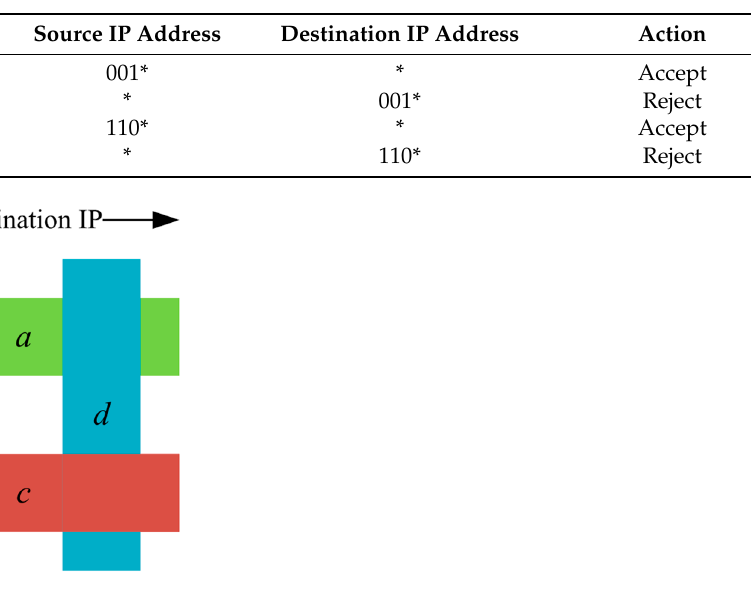
Figure 1. Rectangular presentation of filters.